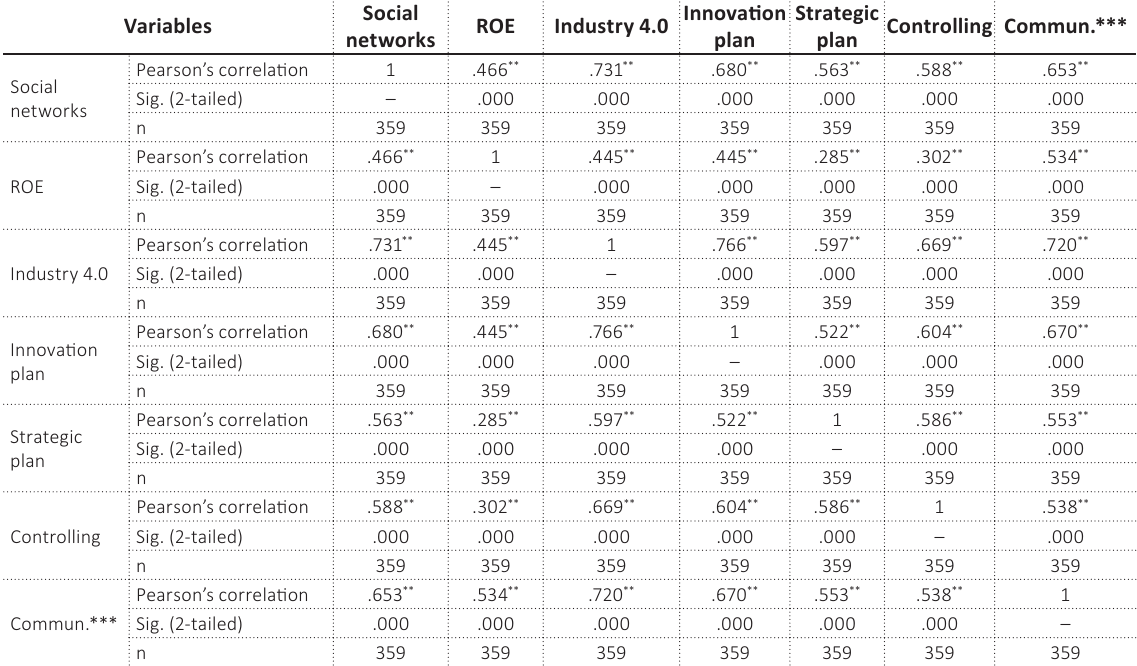
Table 1. Pearson’s correlation of variables